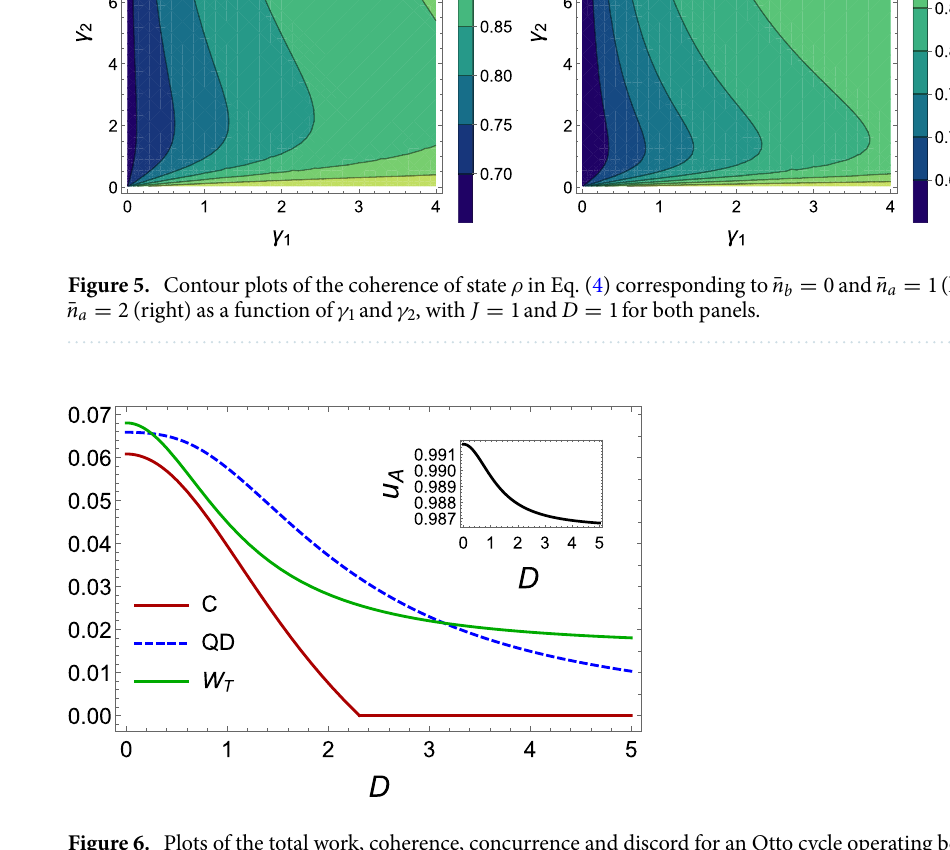
Figure 6. Plots of the total work, coherence, concurrence and discord for an Otto cycle operating between T 1 = 1 and T 2 = 4 using the steady state. We fix J = 1 , γ 1 = 0.1 , γ 2 = 5 , D 2 = 5 , ¯ n a = 2 , ¯ n b = 0 , B 1 = 1 and B 2 = 2 , and change D